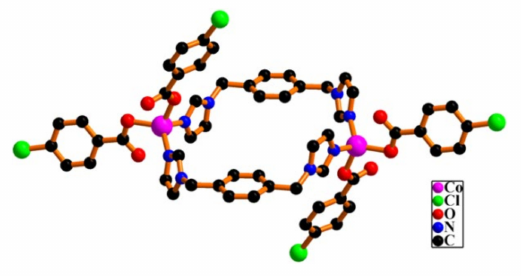
Figure 6. The [Co 2 (pca) 4 (bimb) 2 ] structure